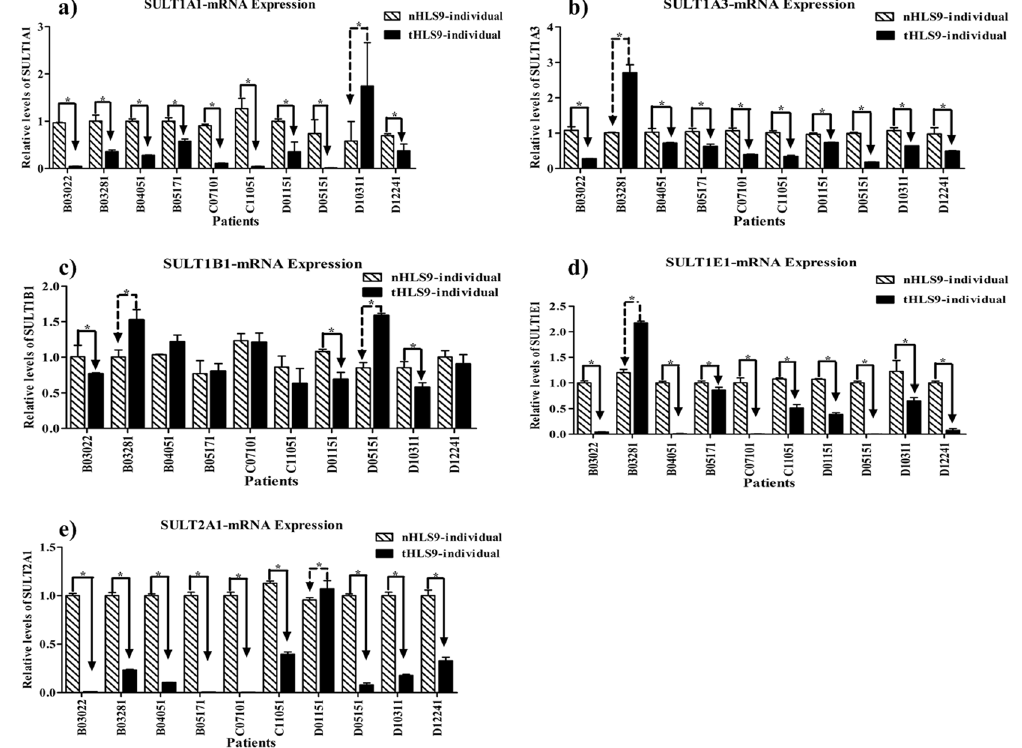
Figure 6. mRNA expressions of the five SULT enzymes in tumors and matched pericarcinomatous tissues of 10 human liver S9 samples with HCC ( a – e ). Relative expression differences were calculated through the comparative ΔΔ Ct method, and Ct values were normalized to GAPDH expression levels. All measurements were performed in triplicate and the relative expression levels of the target genes were presented as 2 −ΔΔ Ct . Data are presented as mean ± SD. Paired-sample t- test was used for data analysis, and P < 0.05 was regard as statistically significant.